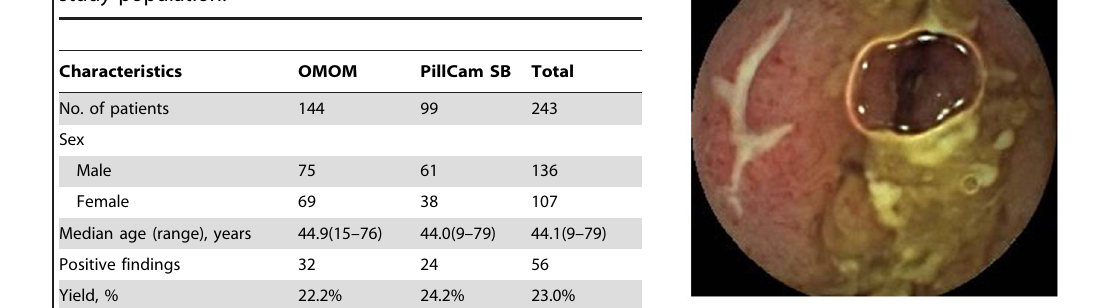
Table 1. Demographic data and clinical characteristics of the study population.